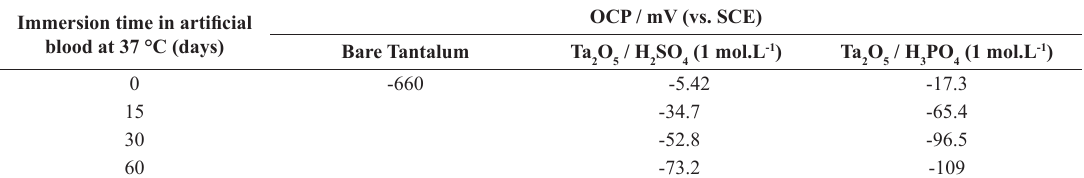
Table 2. OCP values for bare tantalum and its oxides obtained in H blood by 15, 30 and 60 days. Immersion time in artificial blood at 37 °C (days)